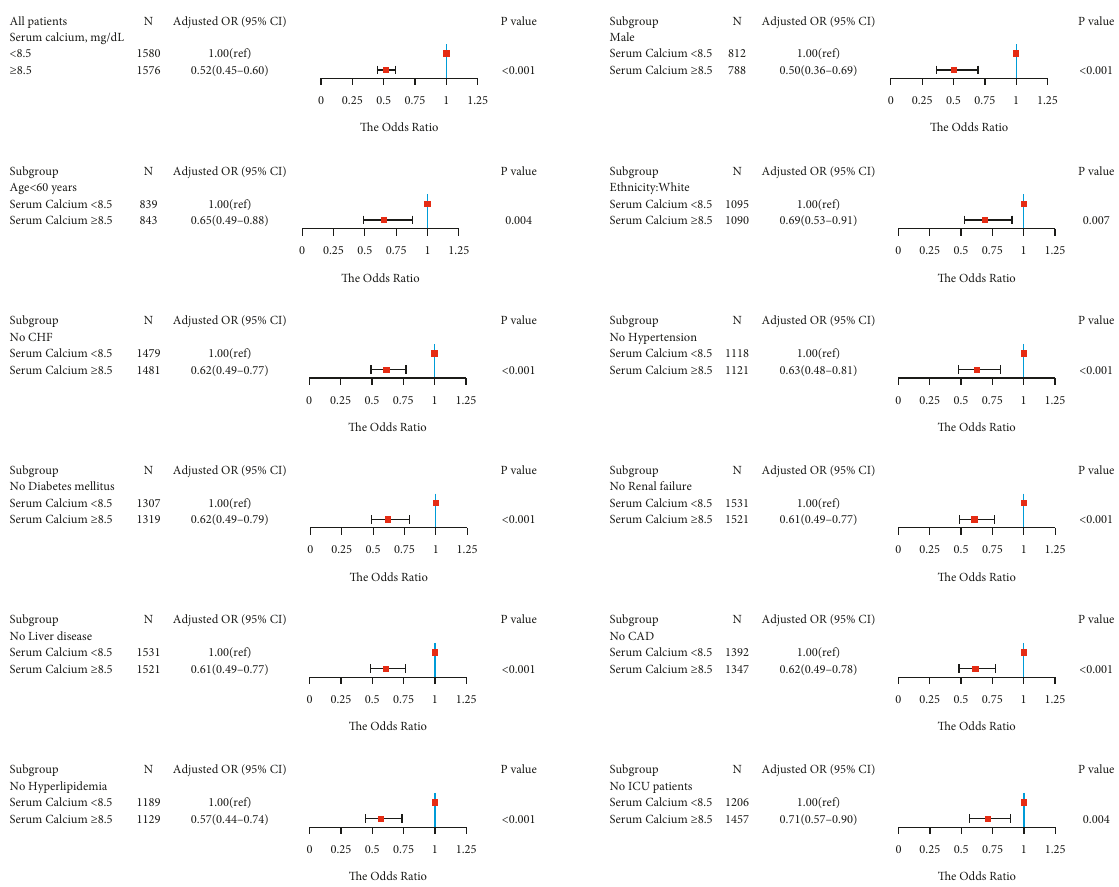
Subgroup ≥8.5No Diabetes mellitus Serum Calcium <8.5 Serum Calcium Subgroup ≥8.5No Liver disease Serum Calcium <8.5 Serum Calcium Subgroup ≥8.5No Hyperlipidemia Serum Calcium <8.5 Serum Calcium Figure 3: Results of subgroup analyses of the serum calcium level and a hospital length of stay (LOS) > 2 days according to clinical characteristics.